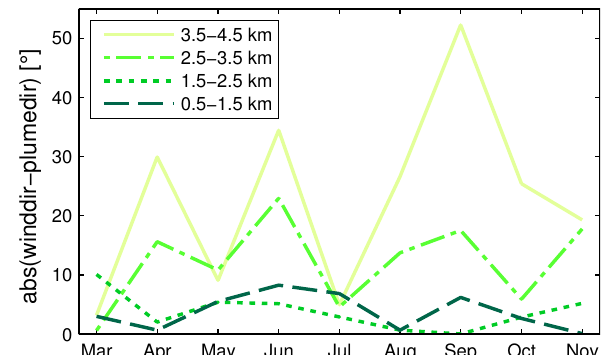
Figure 3. Absolute deviation between the outflow direction of the SO 2 plume and the mean ECMWF wind direction for different alti- tudes for March–November 2008. Wind directions above 2.5km do not match the observed movement of the